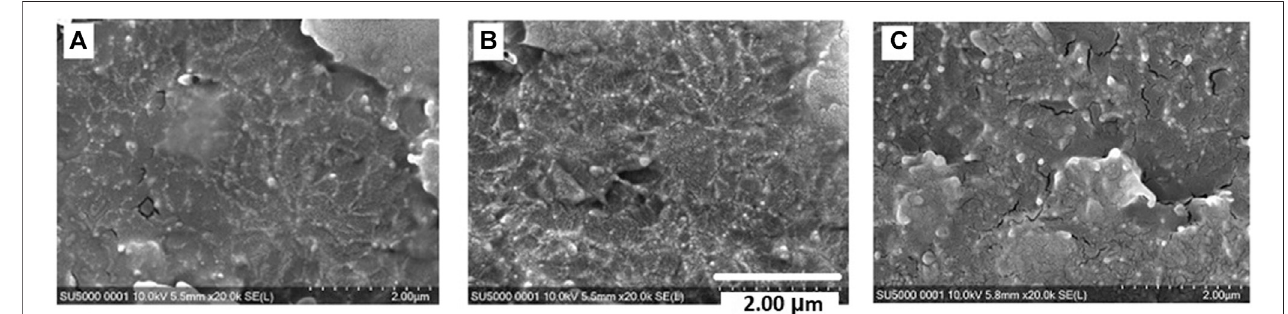
FIGURE 3 | SEM images of PEEK nanocomposites containing (A) 0.5 wt%, (B) 1 wt%, and (C) 2 wt% IF-WS 2